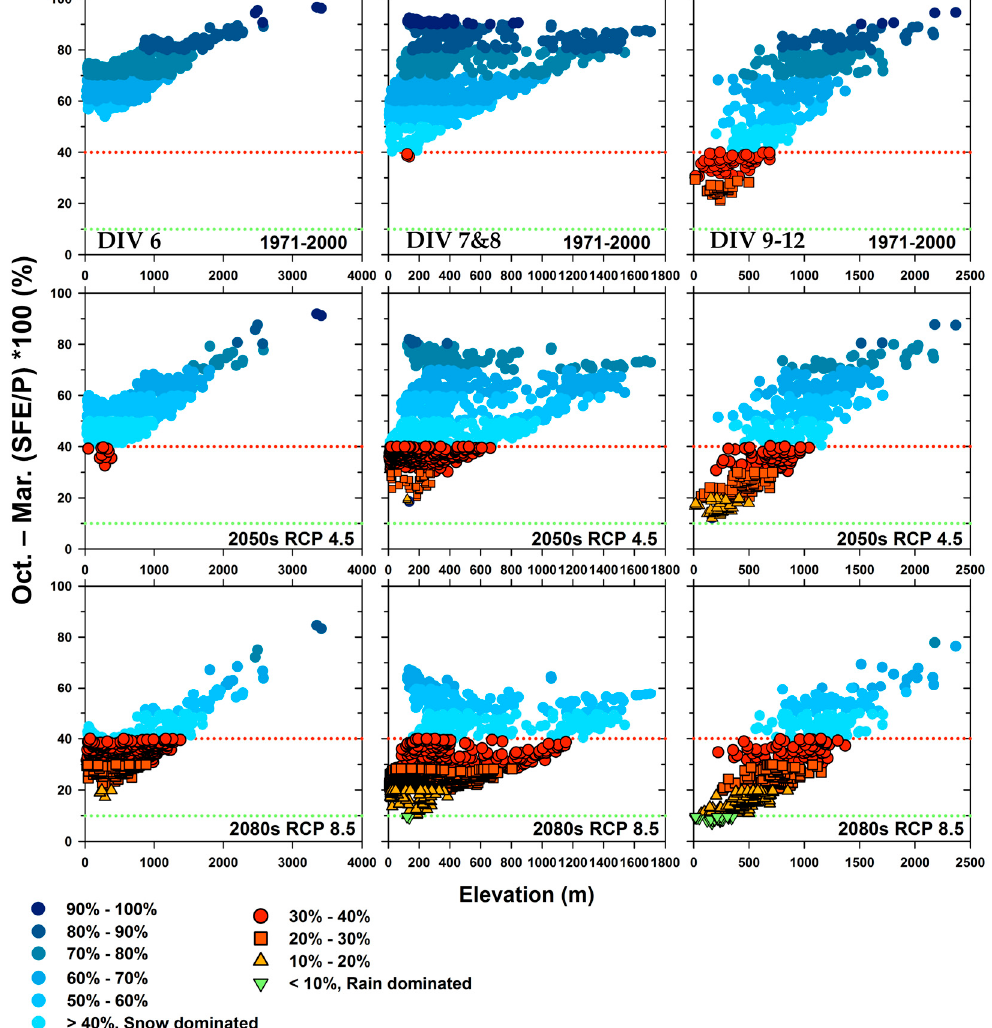
Figure 6. HUC12 watershed mean elevation versus five-model mean projected October–March SFE:P ratio for RCP 8.5. SFE:P is expressed in percent. Alaska Climate Division 6 (Cook Inlet, left ), Divisions 7 and 8 ( center ), and Divisions 9–12 ( right ) for historical ( top row ), 2050s ( middle row ) and 2080s ( bottom row ). Table 7. Fraction of HUC12 watersheds with snow dominated SFE:P ( ≥ 0.4) by Alaska Climate Division and climate scenario.